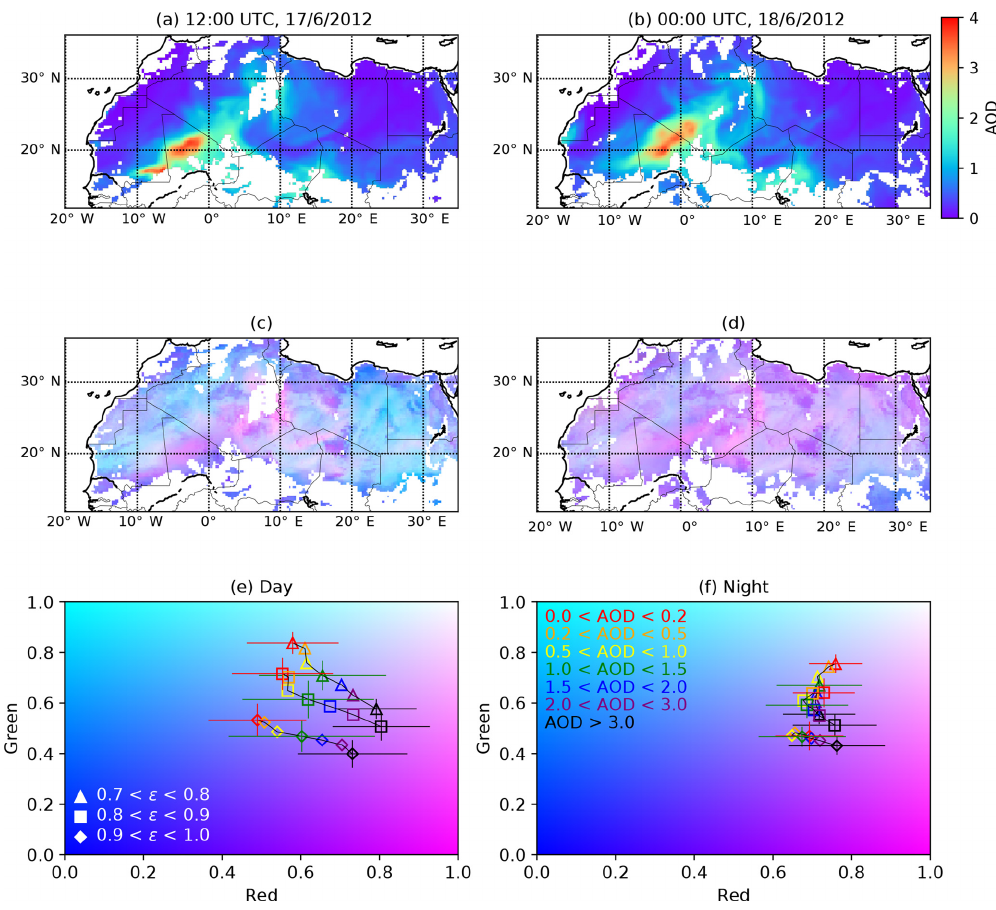
Figure 6. Maps of COSMO-MUSCAT-simulated AODs (a, b) and synthetic Desert Dust RGB images (c, d) : (a, c) 12:00UTC on 17 June 2012; (b, d) 00:00UTC on 18 June 2012. Panels (e) and (f) are plots of mean colours with respect to COSMO-MUSCAT AODs (at 550nm), and surface emissivity is at 8.7µm in June and July 2011–2013. Time slots are 09:00, 12:00, and 15:00UTC (day) for panel (e) and 00:00, 03:00, and 21:00UTC (night) for panel (f) . AOD ranges are marked by symbol colour as indicated, and emissivity ranges are marked by the symbol shapes, as indicated. The blue beam has a fixed value of 1. A total of 0.04% of points have blue values of less than 1 during daylight hours and 5.47% at night. Error bars indicate the standard deviations associated with the colour means but are only included for three of the AOD ranges, for